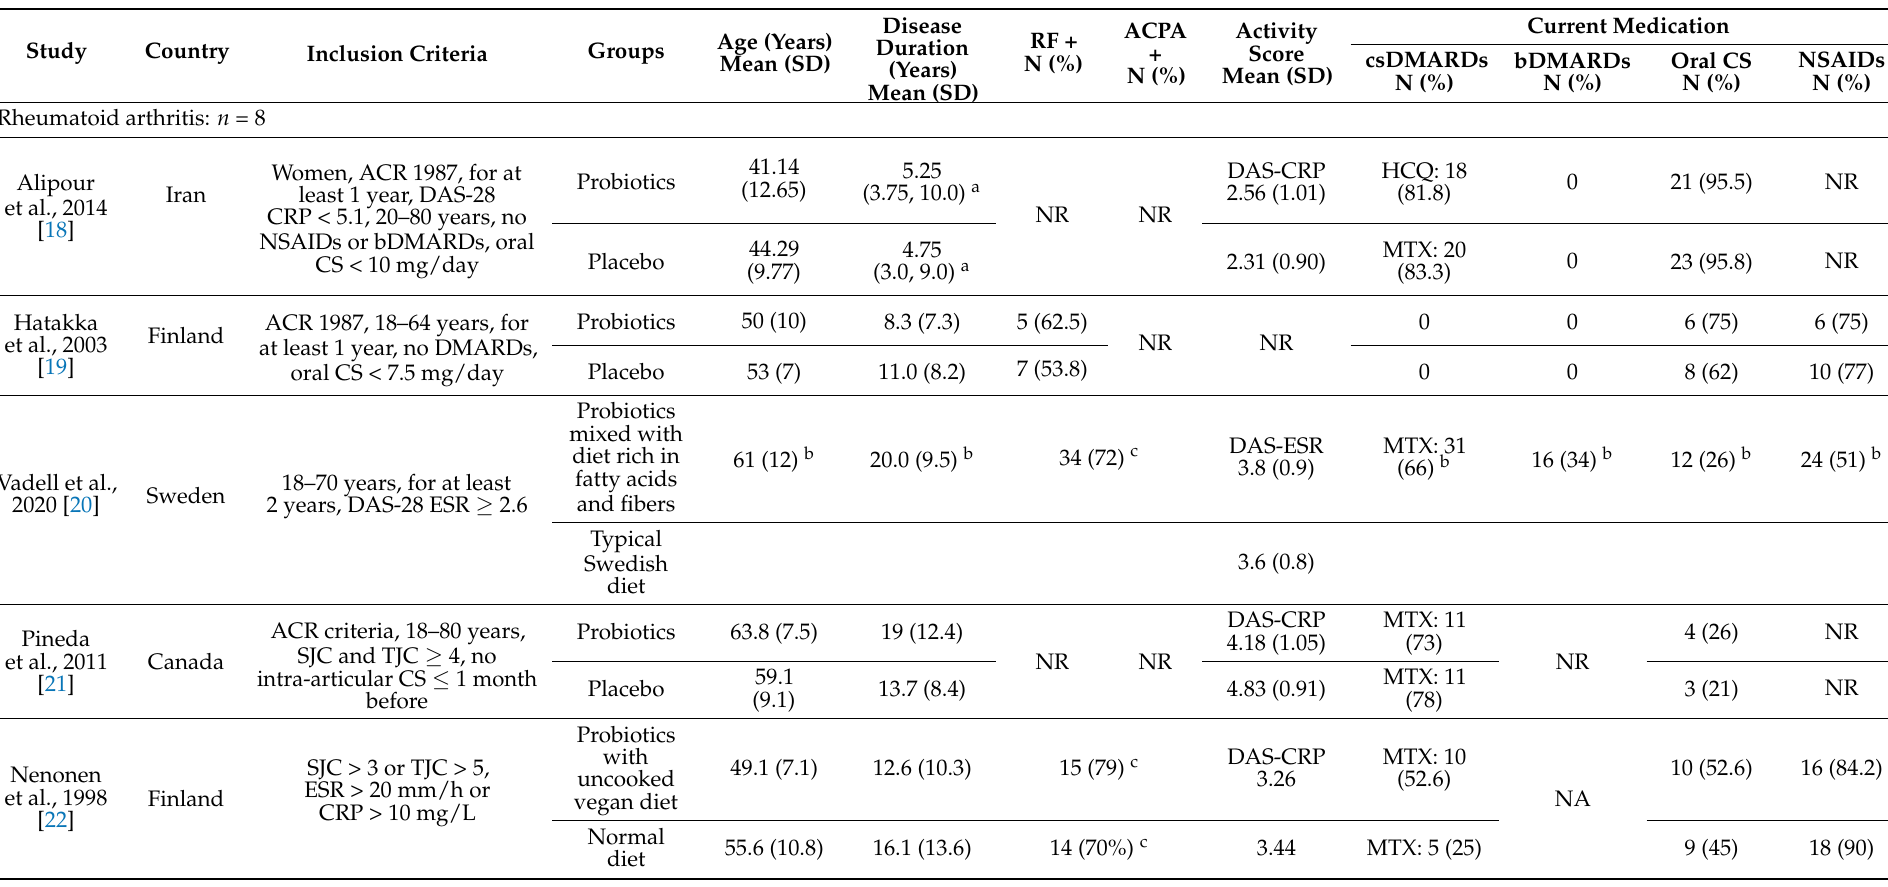
Table 1. Baseline characteristics of patients included in the